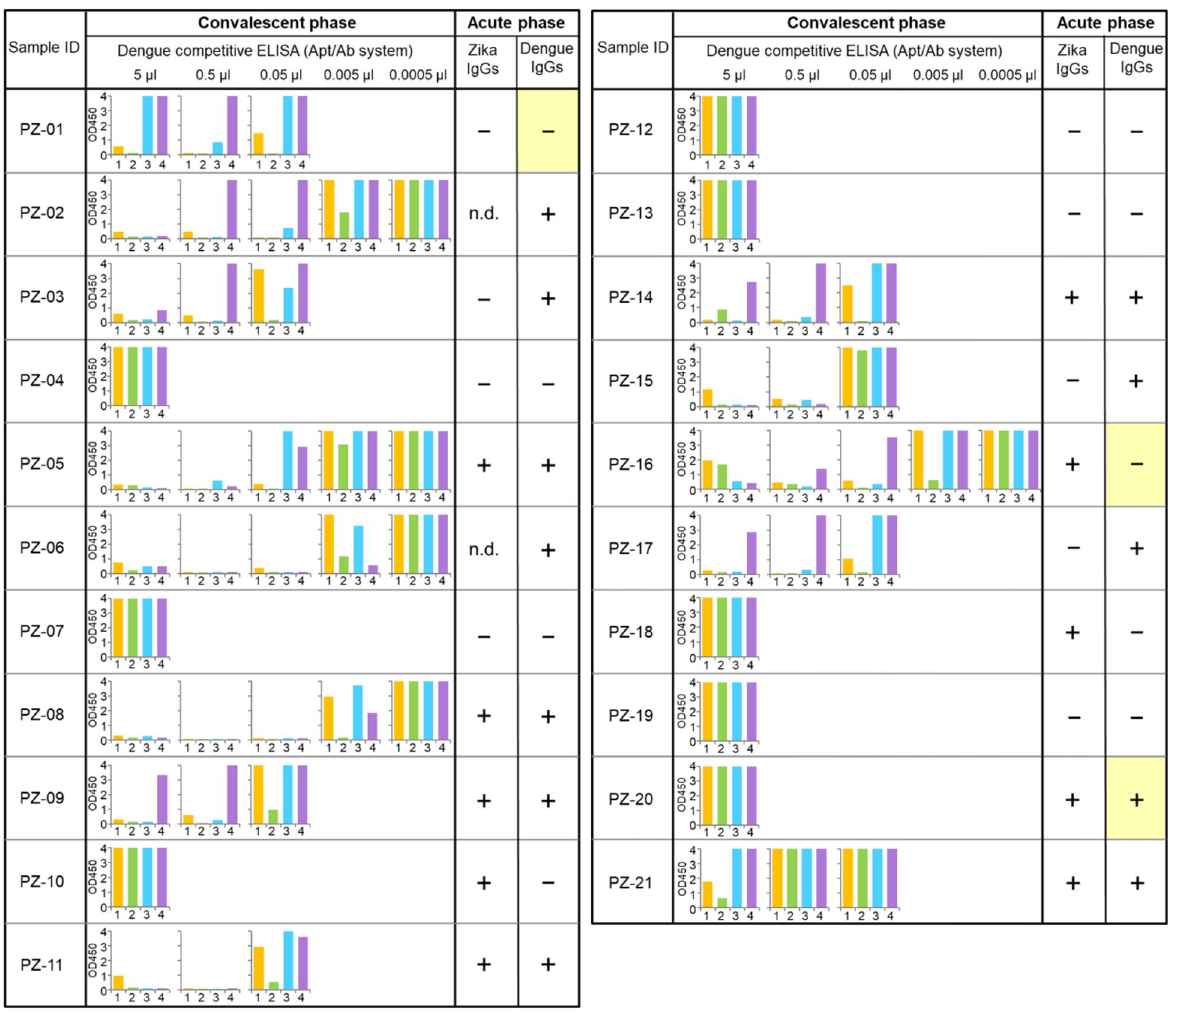
Figure 8. Serotype-specific anti-DENV-NS1 IgG detection using convalescent-phase ZIKV clinical samples by the competitive Apt/Ab ELISA format. For the competitive ELISA tests, 5 µL of diluted plasma samples (corresponding to the use of 0.0005–5 µL) were used and the amounts of the spiked DEN-NS1 were adjusted to obtain similar signal intensities, as shown in Supplementary Fig. 1. ZIKV IgG detection patterns in each acute- phase sample are from the ELISA results reported previously 74 and Dengue IgG detection patterns are from the tests using the SD BIOLINE Dengue Duo kit (Dengue IgG/IgM test). n.d. not determined (not